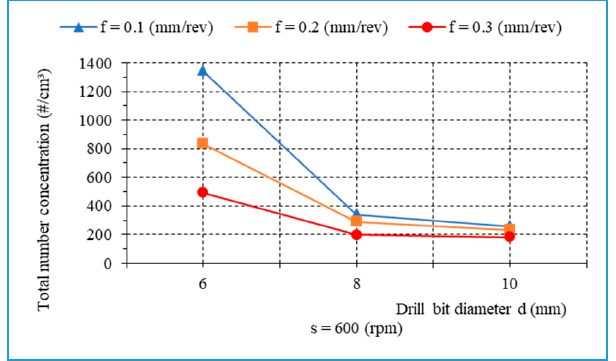
Figure 21. The number of fine particles related to drill bit diameter when drilling, with di ff erent feed rates, s = 600 rpm.